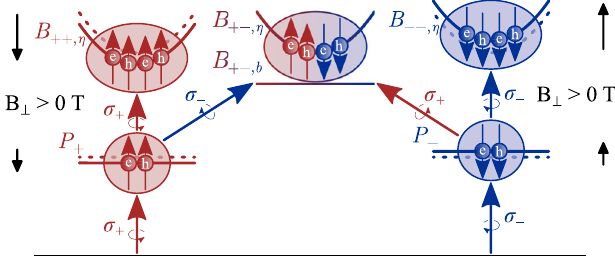
FIG. 5. Illustration of Zeeman shifts of exciton and two-exciton scattering continua in the presence of an out-of-plane magnetic field B ⊥ > 0 T; cf. also Fig. 1(b). For B ⊥ > 0 T, the exciton transitions P and continua B shift to lower energies, þ þþ ; η ≠ b whereas P − and B −− shift to higher energies. The biexciton ; η ≠ b B and continua B experience no shift. þ − ;b þ − ; η ≠ b